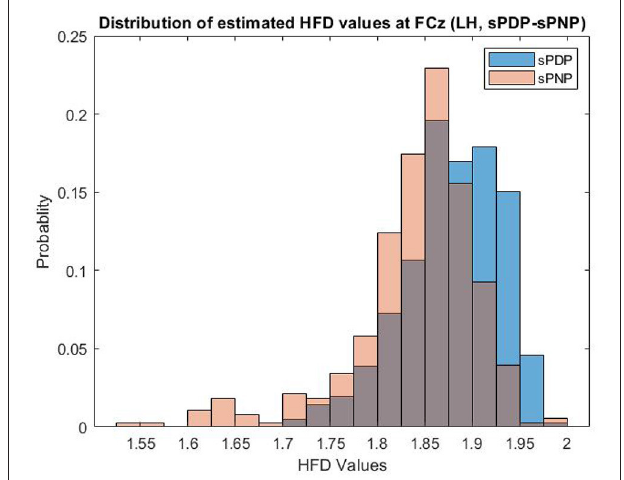
FIGURE 3 | Example distributions of HFD estimated from EEG data of both participant groups in Dataset 2 at one electrode (FCz) during Left Hand (LH) movement imaginations. HFD values range from 1.5 to 2.0 and are most frequently close to 1.85, with a larger proportion of HFD features extracted from EEG data of participants in the group sPNP at lower values, and a larger proportion of HFD features extraced from EEG data of participants in the group sPDP at higher